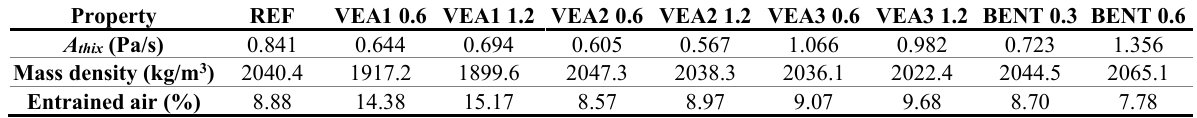
Table 4 S tructuration rate, mass density and entrained air of the